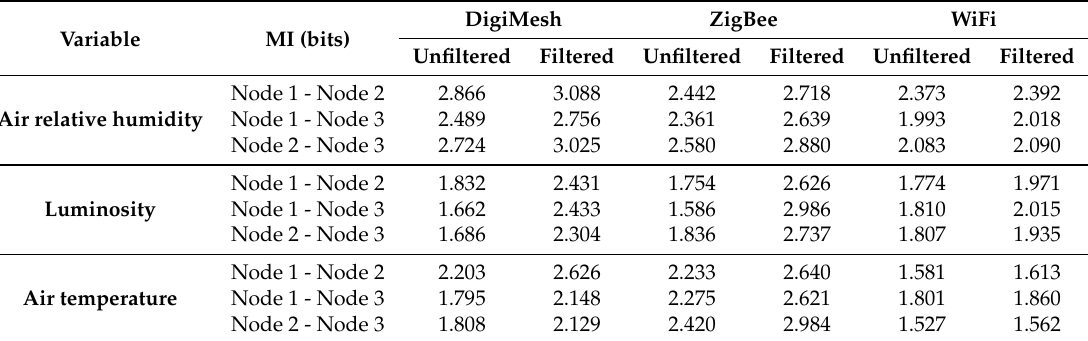
Table 3. MI results compared between two sensor nodes of the same WSN.